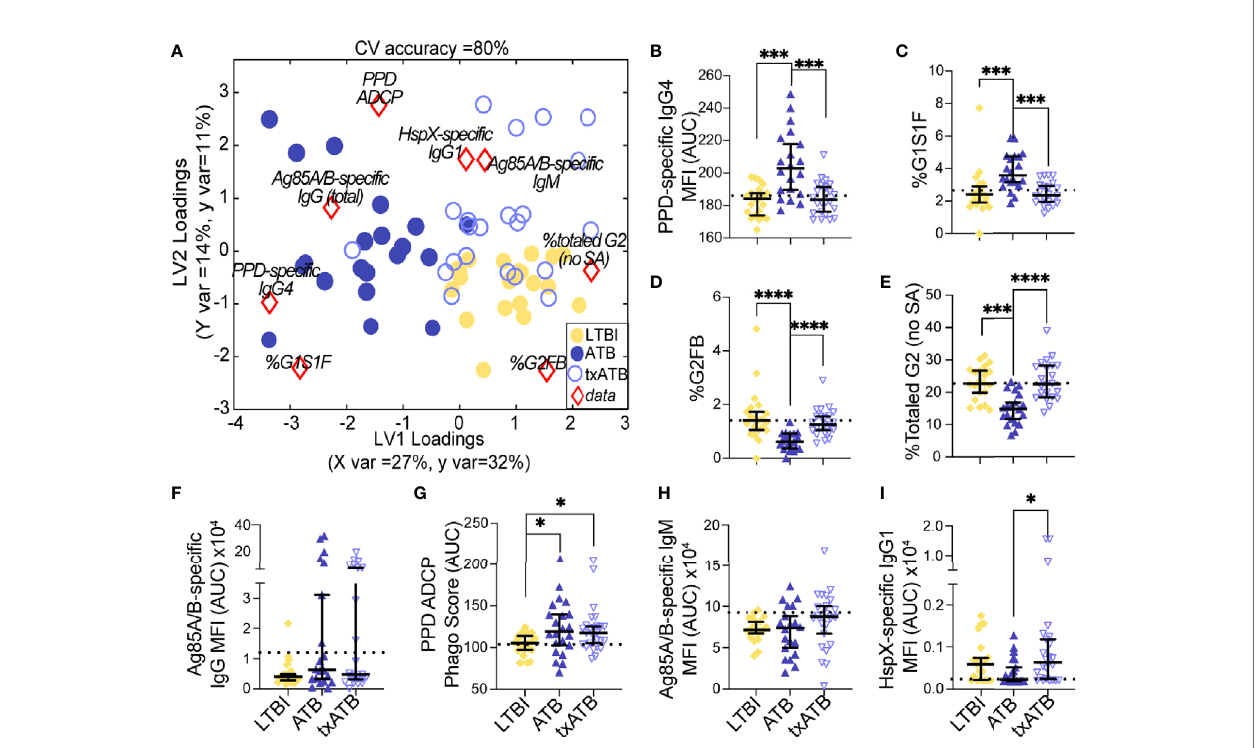
FIGURE 4 | Fc-glycans, TB-speci fi c titers, and isotypes distinguish individuals on the TB spectrum. Three-way comparison of LTBI (n = 21, yellow dots and diamonds), ATB (n = 20, blue dots and triangles), and txATB (n = 23, periwinkle dots and triangles) individuals. (A) Using the features described in Figures 2 – 4 , a three-way PLSDA analysis summarizes the comparison of LTBI, ATB, and txATB. The depicted biplot overlays the scores plots of individuals color-coded based on their TB status on the two-dimensional loading plots of the 8 input features (red diamonds). LV1 accounts for 27% of variance in X and 32% of variance in Y, whereas LV2 explains 14% X variance and 11% Y variance. To assess the model performance, 5-fold cross validation was performed resulting in 80% CV accuracy. Permutation testing results showed that this model outperformed 90% of models based on shuf fl ed group labels (Wilcoxon p = 0.1). (B) AUC of PPD-speci fi c IgG4 titers. (C) frequency of G1S1F glycan on IgG (D) frequency of G2FB glycan on IgG (E) The frequencies of totaled G2 structures without sialic acid on IgG-Fc. (F) AUC Ag85A/B-speci fi c total IgG titers. (G) PPD-speci fi c ADCP Phago Score. (H) AUC Ag85A/B-speci fi c IgM titers (I) AUC HspX-speci fi c IgG1 titers. Univariate plots (B-I) show median and interquartile range of the measured values and statistically signi fi cant differences between LTBI, ATB, and txATB groups were calculated using Kruskal-Wallis test with Dunn ’ s multiple comparison test correction: *p < 0.05, ***p < 0.0005, and ****p <